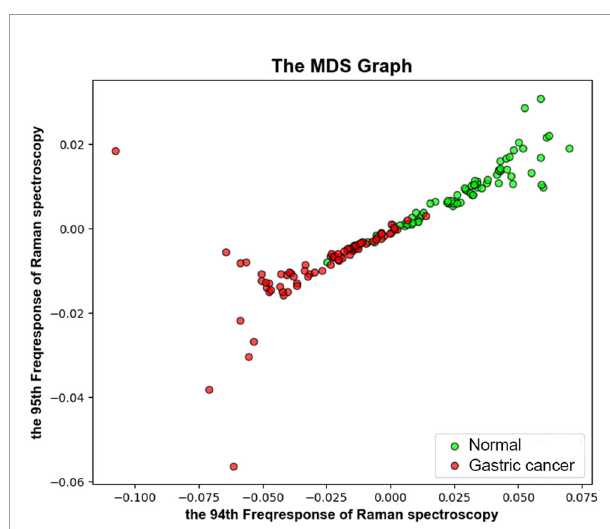
FIGURE 5 | The scatter plots of the gastric cancer group and the normal group based on the spectral frequency response characteristics of the random forest (RF) classi fi cation model. Red represents the gastric cancer group, and green represents the control group.